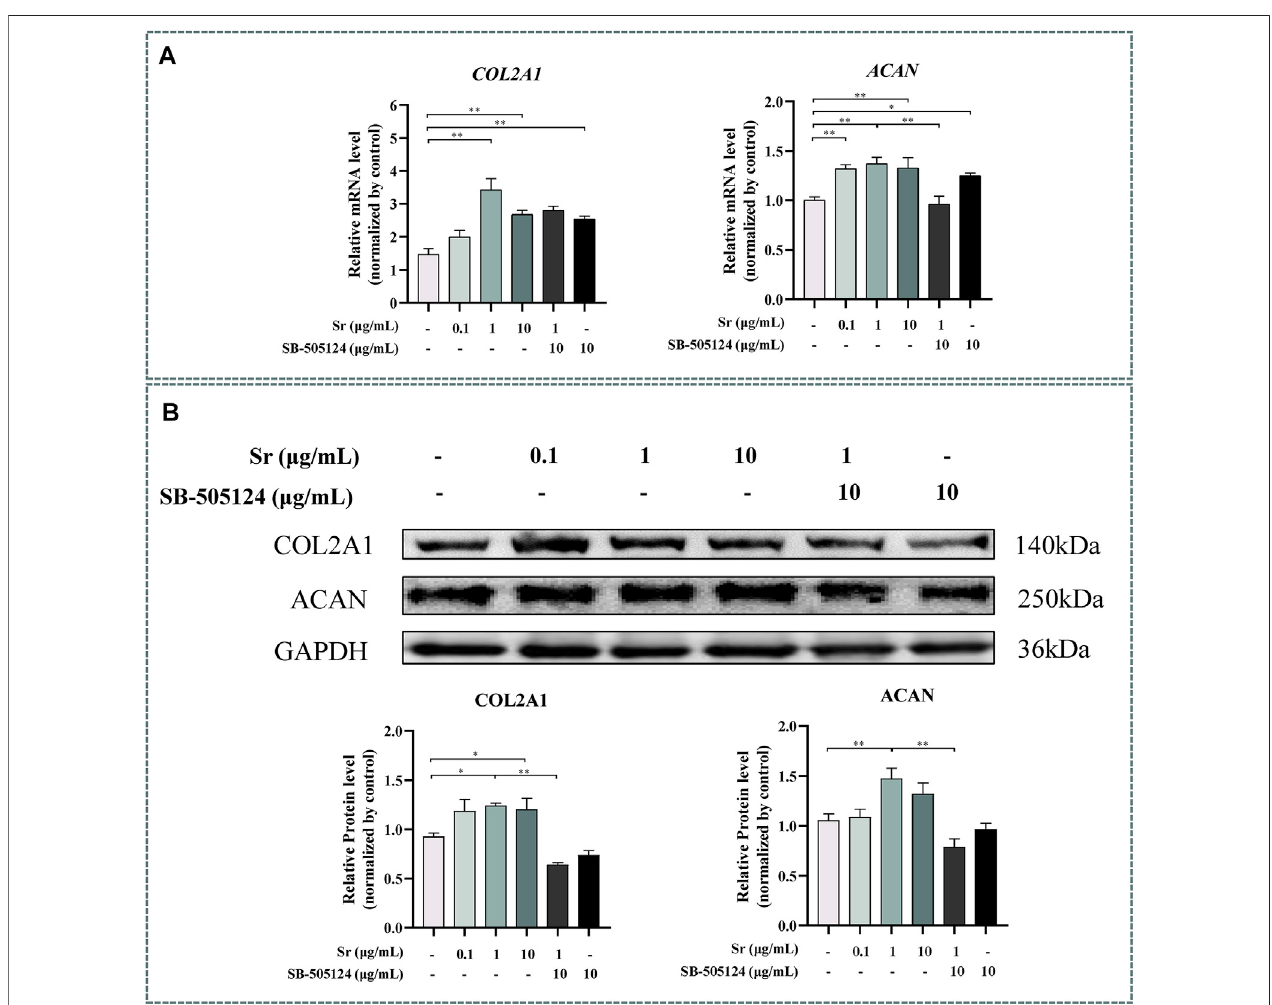
FIGURE 3 | Effects of Sr and SB-505124 on proliferation-related factors in bovine chondrocytes. Chondrocytes were treated with different doses of Sr (0, 0.1, 1, 10 μ g/ml) with or without activin receptor-like kinase 5 (ALK5) kinase inhibitor(10 μ M SB-505124). (A) Relative mRNA expression levels oftype Ⅱ Collagen α 1 (COL2A1) andaggrecan(ACAN). (B) WesternblotandproteinexpressionlevelsofCOL2A1andACAN.Allexperimentswererepeatedatleastthrice.Dataaremeans±SEM( n =3 in each group) * p < 0.05; ** p < 0.01.